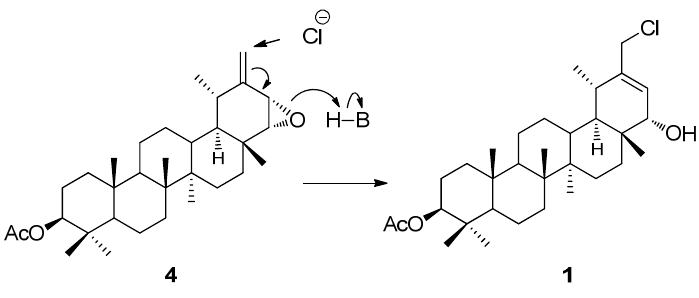
Figure 4. Tentative forming process of compound 1